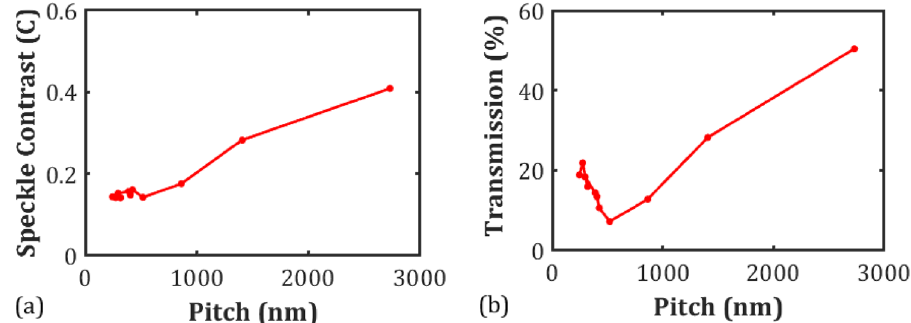
Figure 3. Plots of the minimum speckle contrast ( a ) and transmission ( b ) as a function of the pitch of the chiral nematic LC device. Measurements were carried out at 25 °C using a 20 µm-thick device for mixtures consisting of E7 and the chiral dopant BDH1281 (0.5–6.4 wt%). The solid red lines represent a linear interpolation to guide the eye.